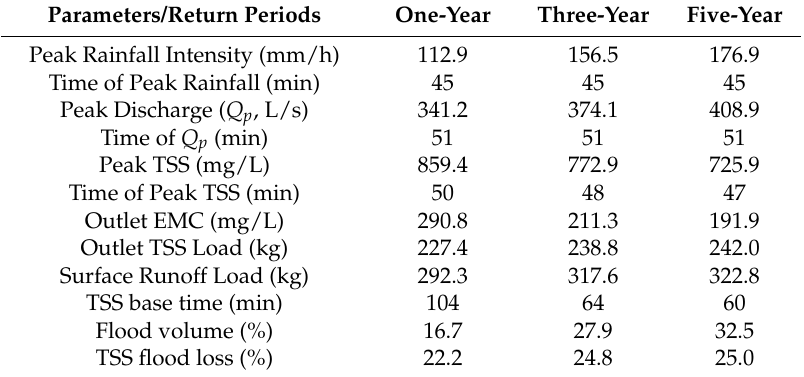
Table 6. Summary of simulated flow and TSS concentration characteristics for the 2-h K&C design storms ( r = 0.375) with three different return